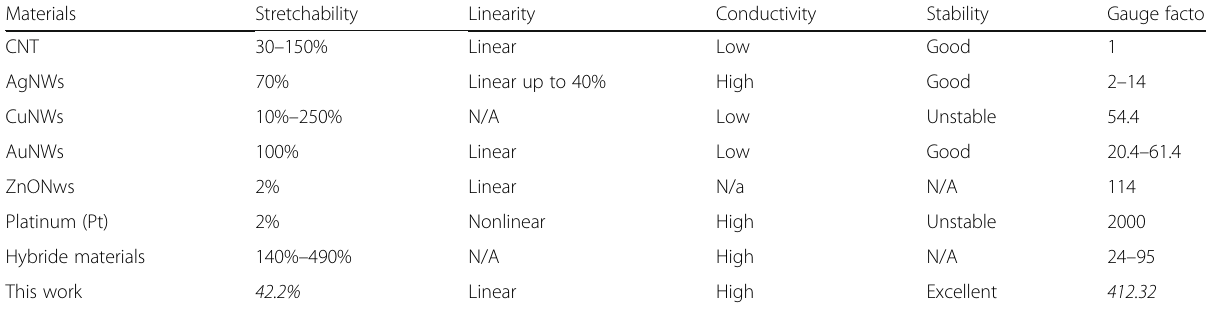
Table 1 Performance comparison of soft strain sensor materials